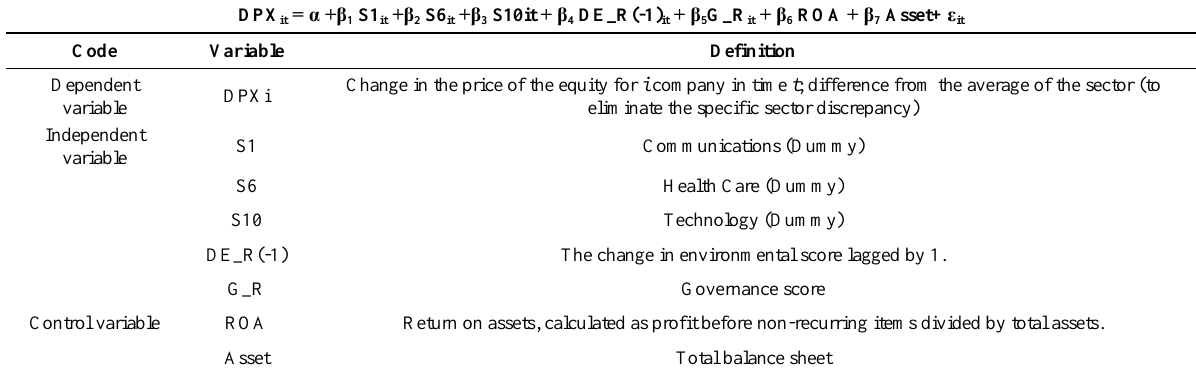
Table 4. OLS regresion estimation (EViews